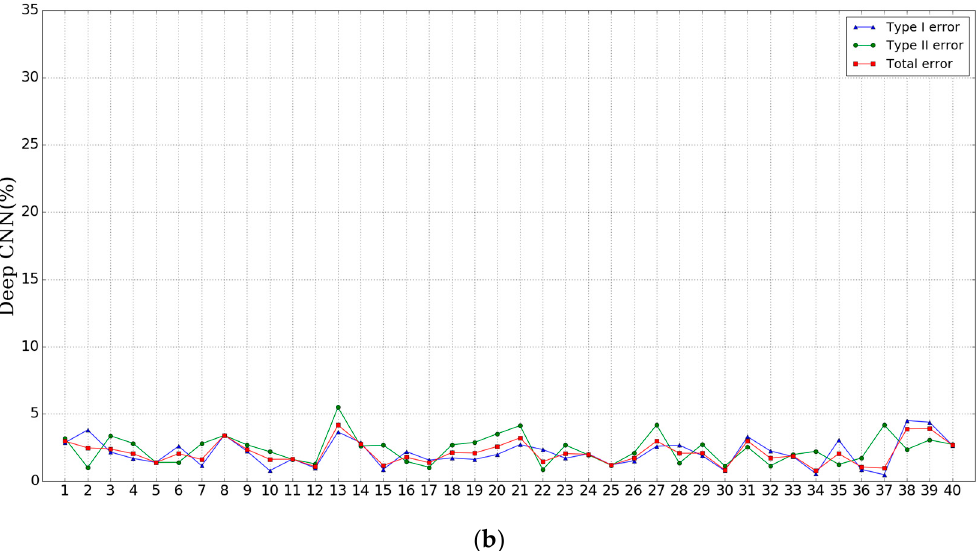
Figure 7. Error rate of TerraScan ( a ) and Deep CNN ( b ) in 40 test cases.